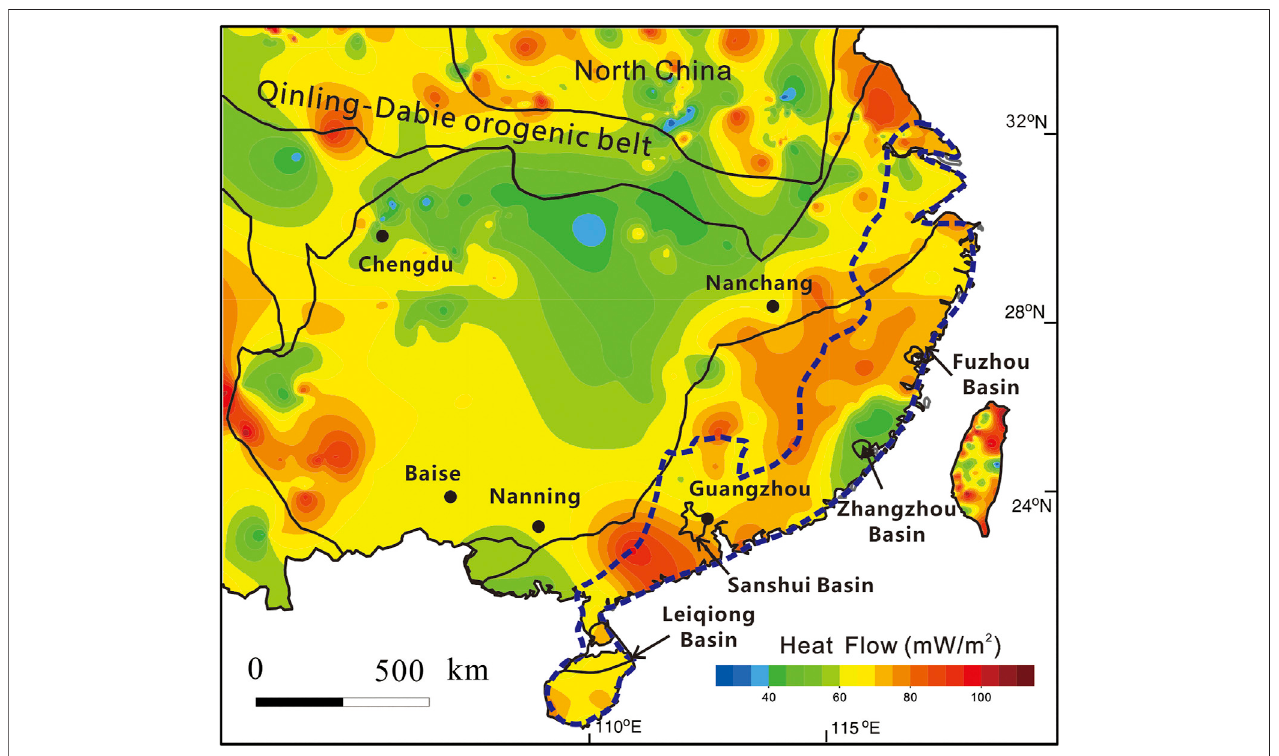
FIGURE 2 | The Heat fl ow map distribution of the study area (Modi fi ed after Zhang et al., 2020).